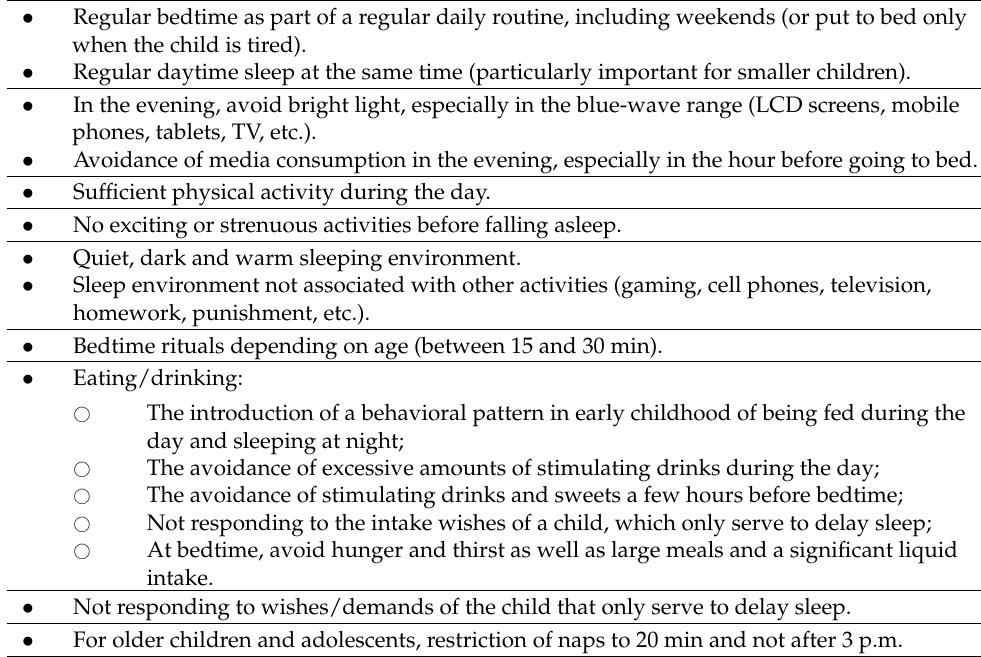
Table 6. Treatment recommendations for non-organic sleep